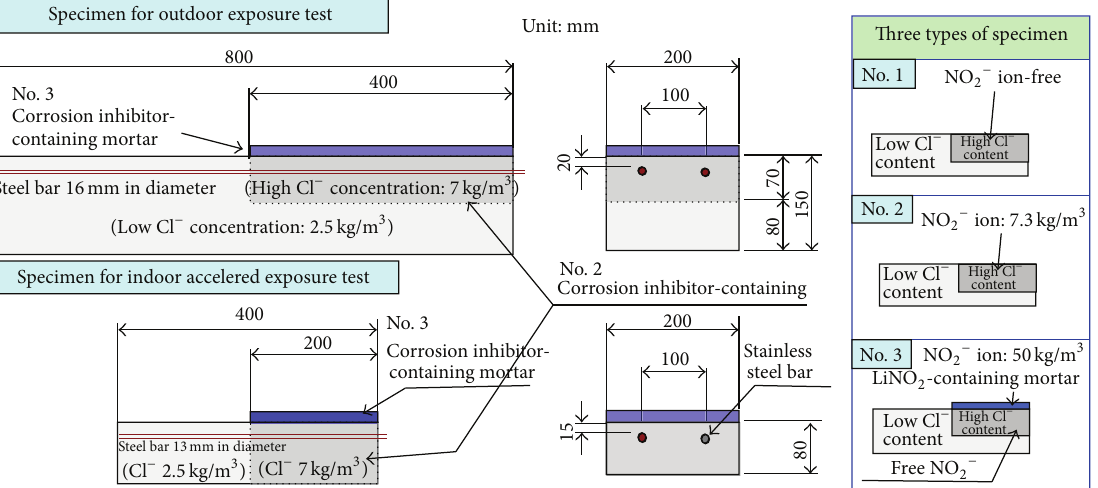
Figure 5: Specimens for the outdoor and the indoor exposure tests.